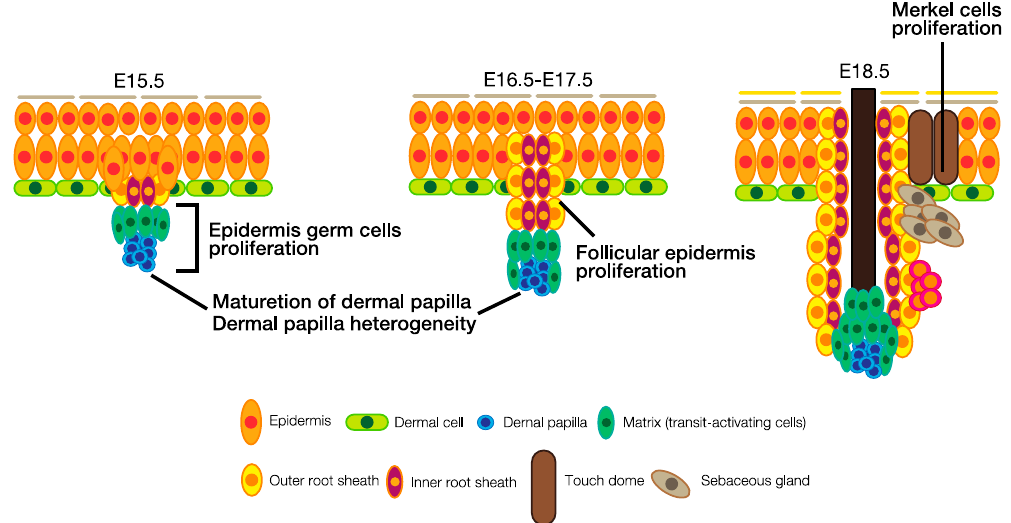
Figure 3. The roles of the HH signaling pathway in embryonic hair follicle development. In epidermal cells, HH signaling is involved in germ cell and follicular cell proliferation. HH signaling is also involved in the maturation of the dermal papilla, as well as dermal papilla heterogeneity. Furthermore, HH signaling is essential for Merkel cell proliferation and touch dome development.